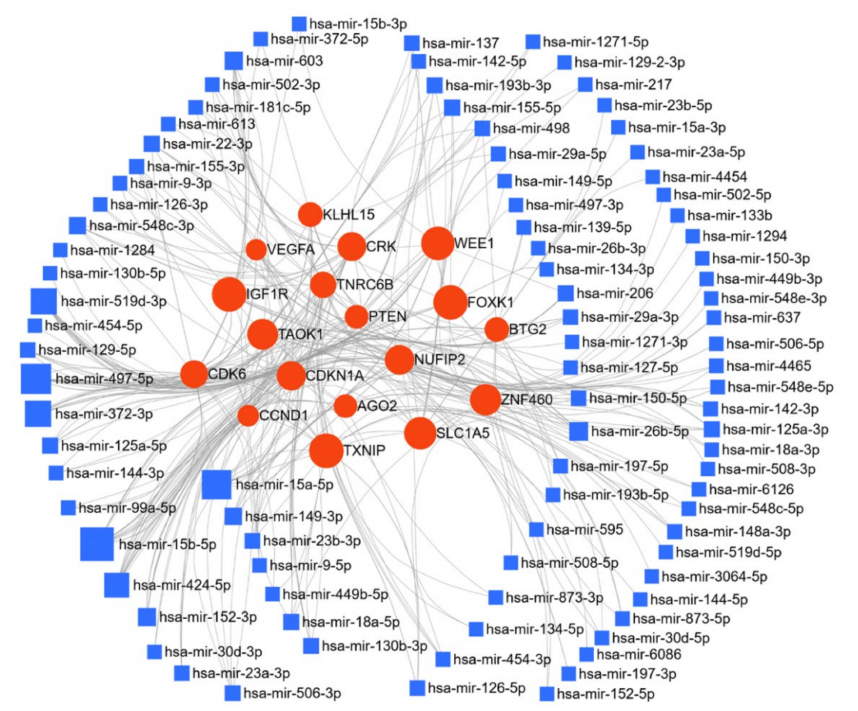
Figure 5. Network of downregulated miR in ovarian cancer: miR deregulated in ovarian cancer were searched for in the PubMed database using IRIDESCENT. The network of downregulated miR generated using miRNET (degree filter cutoff 15) is shown. The blue squares represent miR, and the red dots represent target genes of these